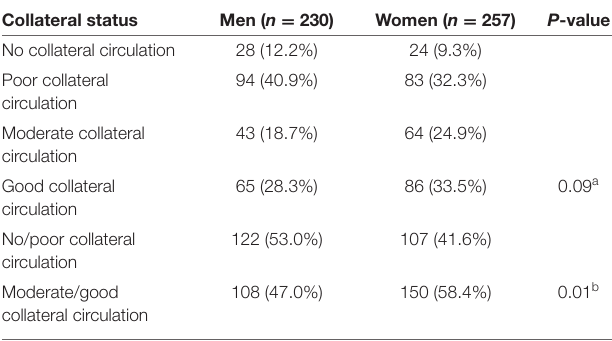
TABLE 2 | Collateral circulation in patients receiving mechanical thrombectomy.